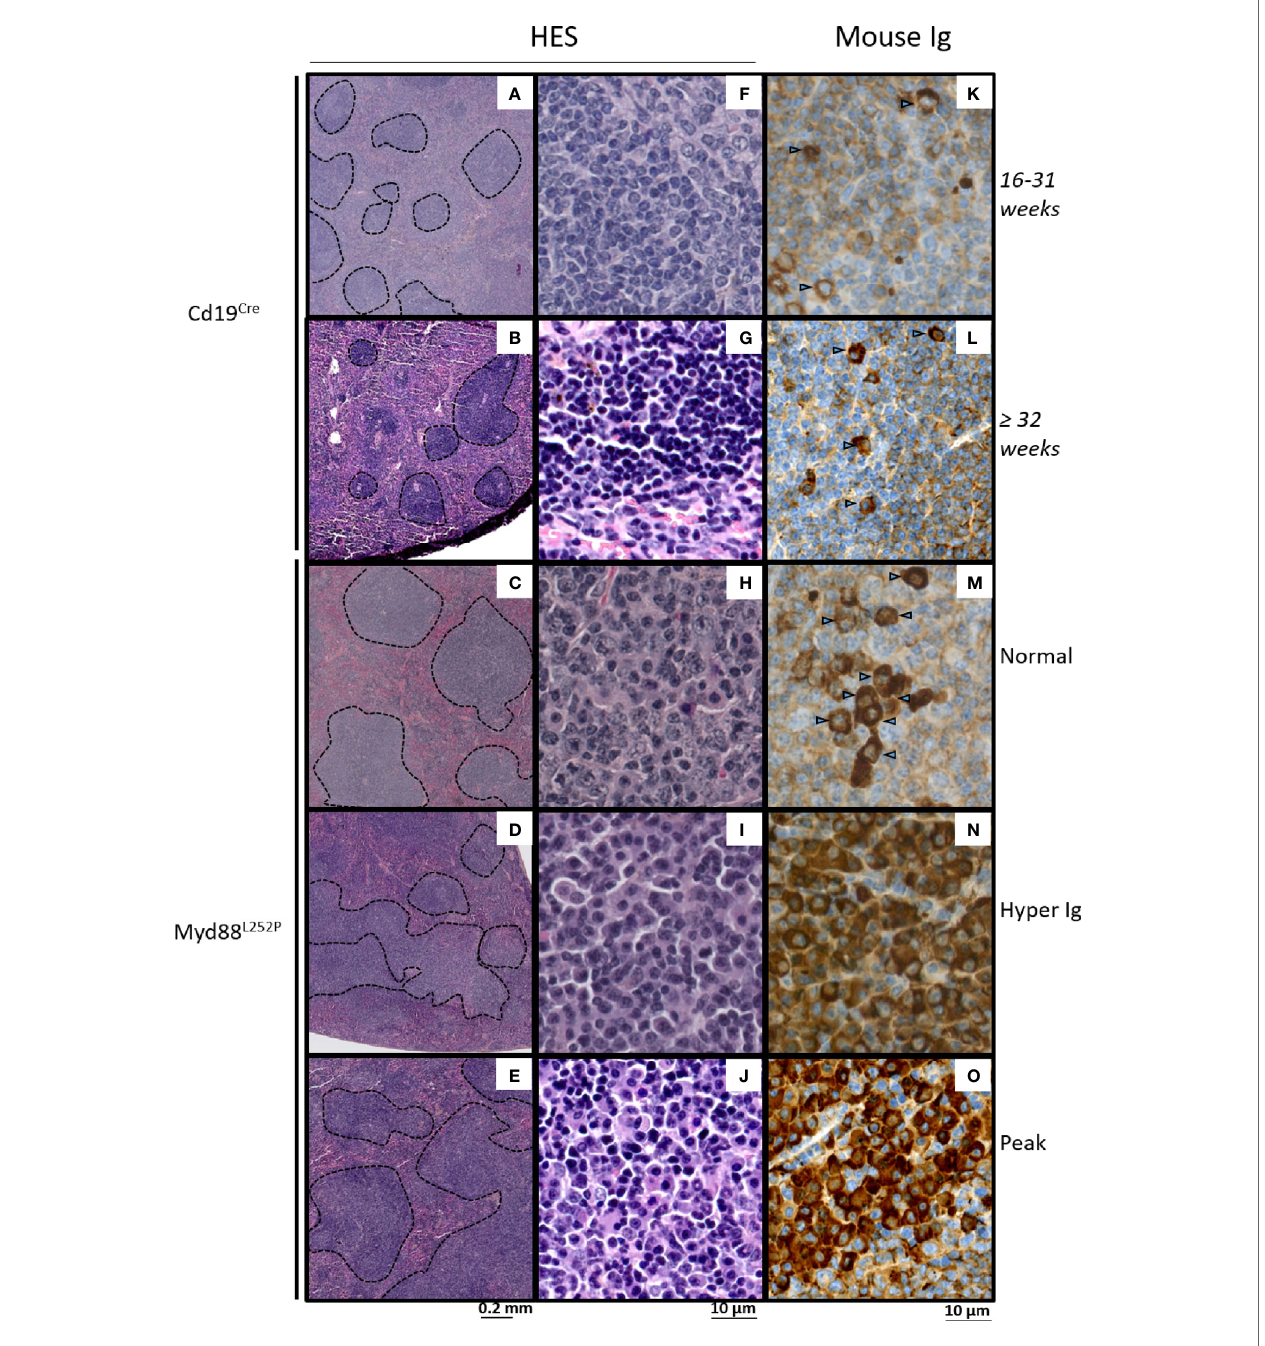
FIGURE 5 | Morphological and immunophenotypic plasma cell engagement of Myd88 L252P tumors. Hematein eosin morphological aspect (A – J) and intracytoplasmic Ig labeling (K – O) of Cd19 Cre and Myd88 L252P spleens: one 16-31 week-old Cd19 Cre (A, F, K) , one ≥ 32 week-old Cd19 Cre (B, G, L) and three Myd88 L252P (C, H, M) for Normal group, (D, I, N) for Hyper Ig group and E, J, O for Peak group) mice are shown. Panels (A – E) at low magni fi cation, Myd88 L252P tumors often exhibited a nodular pattern (C – E) . Panels (F – J) : at high magni fi cation, most Myd88 L252P tumors had small B-cell aspects with marked lymphoplasmacytic engagement (panels H – J) . Panels (K – O) Myd88 L252P tumors with a lymphoplasmacytic aspect exhibited marked plasma cell differentiation as revealed by the presence of intracytoplasmic Ig in numerous cells (arrows) with various labeling intensities (M – O)